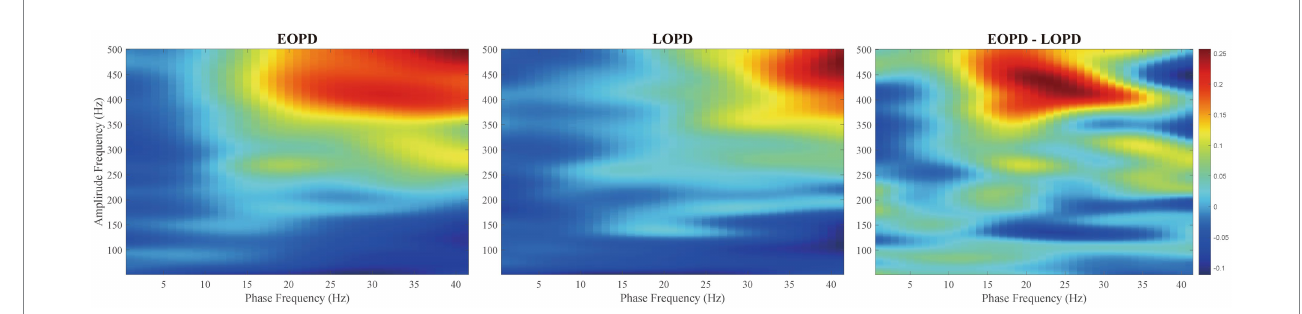
FIGURE 4 Comodulograms of phase-amplitude coupling. Modulation index (MI) was averaged across all EOPD (Left) and LOPD patients (Middle) , with phase frequency (range from 2 to 45 Hz) and amplitude frequency (range from 50 to 500 Hz) shown. (Right) Inter-group comparison showed a significant difference in MI of low beta phase (13–20 Hz) and fast HFO (fHFO, 300–460 Hz) amplitude coupling ( p =